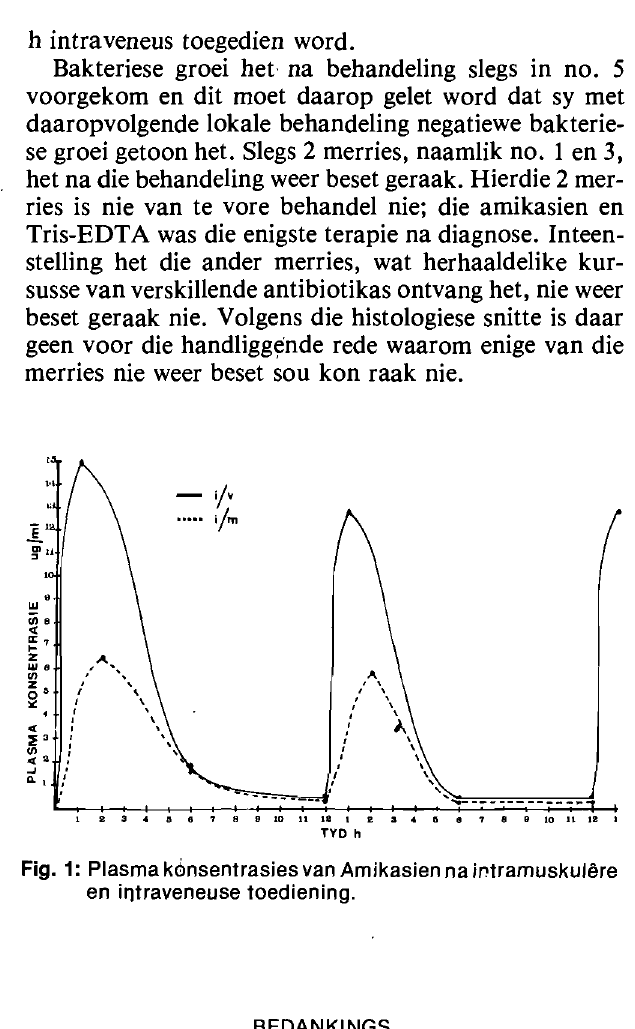
Fig. 1: Plasma kcilnsentrasies van Amikasien na intramuskuJere en irltraveneuse toediening_